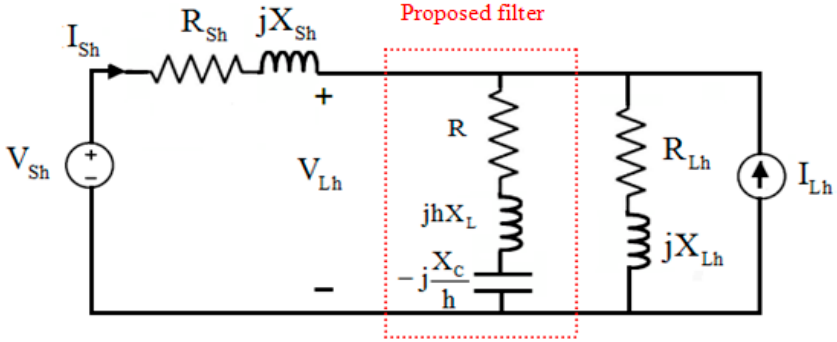
Figure 3. Single-phase equivalent circuit of the compensated system.